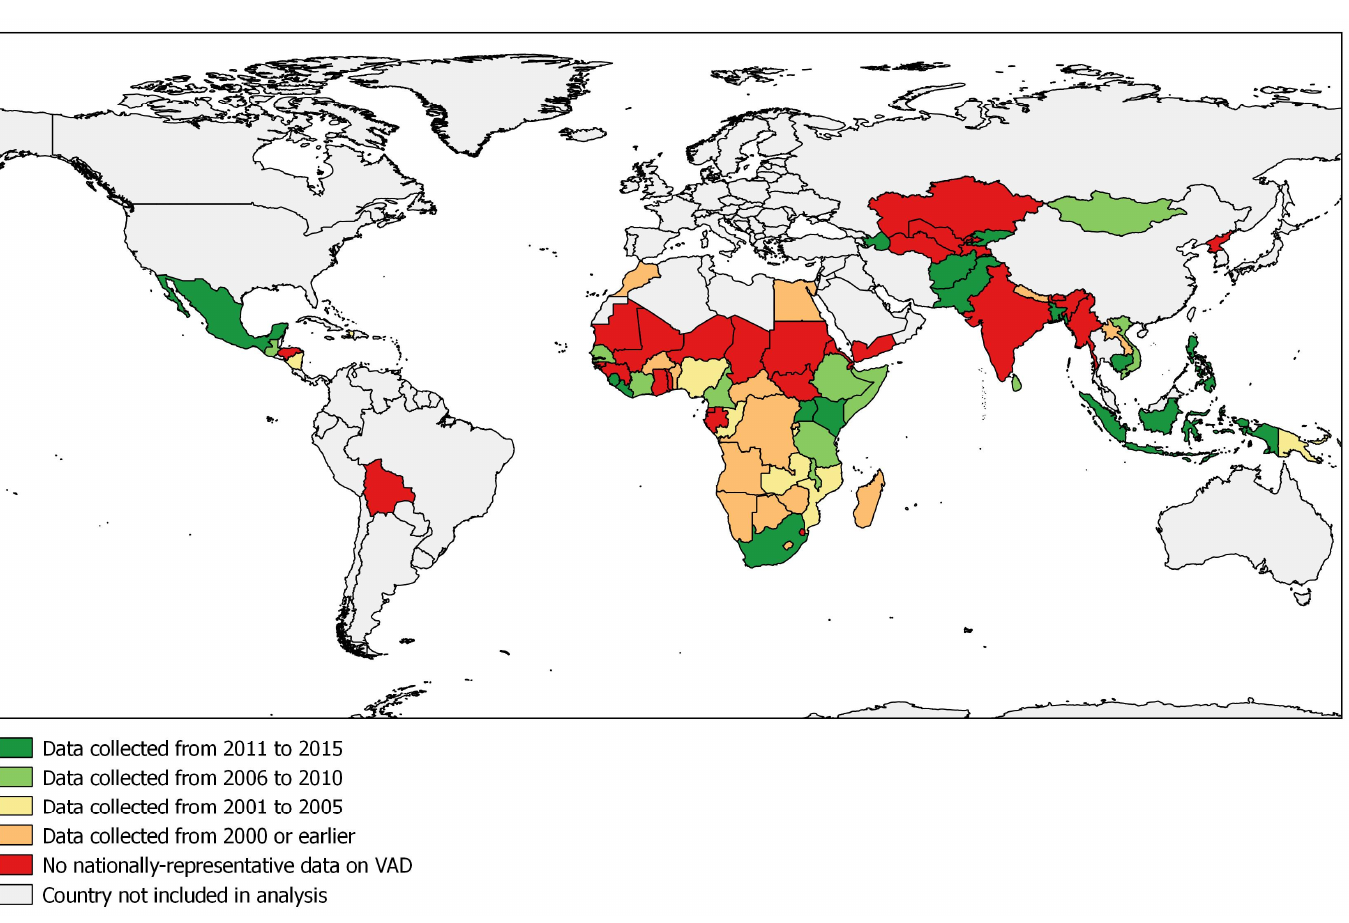
Figure 1. Recentness of nationally-representative data on vitamin A deficiency (VAD).